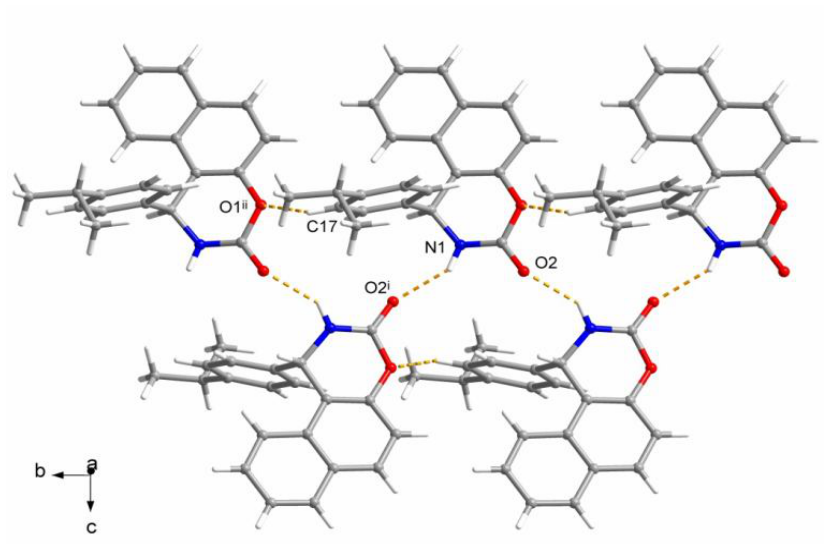
Fig. 2. Molecules of 4i joined to each other via N/C-H···O contacts (dashed lines) to form homochiralchains running down the b-axis. [H···A, D···A, and D–H···A for N(1)-H(1N)···O(2) i : 2.08(2), 2.807(2) Å and 143(2)°; for C(17)–H(17)···O(1) ii : 2.58, 3.187(2) Å and 122°. Symmetrycodes (i) -x+1/2, y+1/2, -z+3/2; (ii) x, y+1, z]. Table 5. Reaction Between 2-Naphthol ( 1 ), Aromatic Aldehydes ( 2 ) and Urea ( 3 ) under Solvent-Free (I) and Microwave-Assisted a (II) Conditions Using 0.01 g Perlite-SO